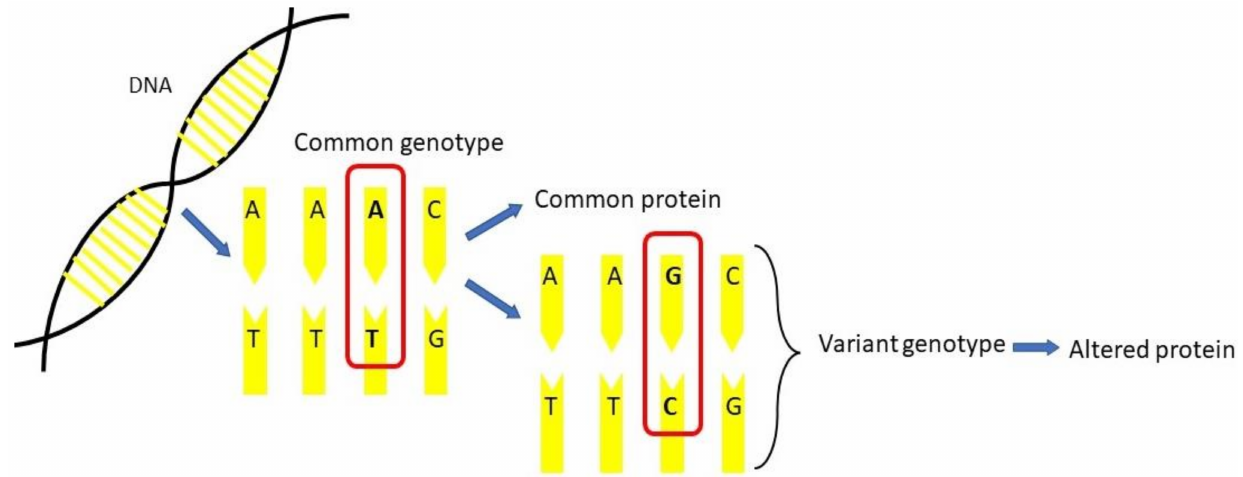
Figure 1. Single nucleotide polymorphisms (SNPs) in the common genotype and variant genotype of DNA (adapted from Iglesias et al.,